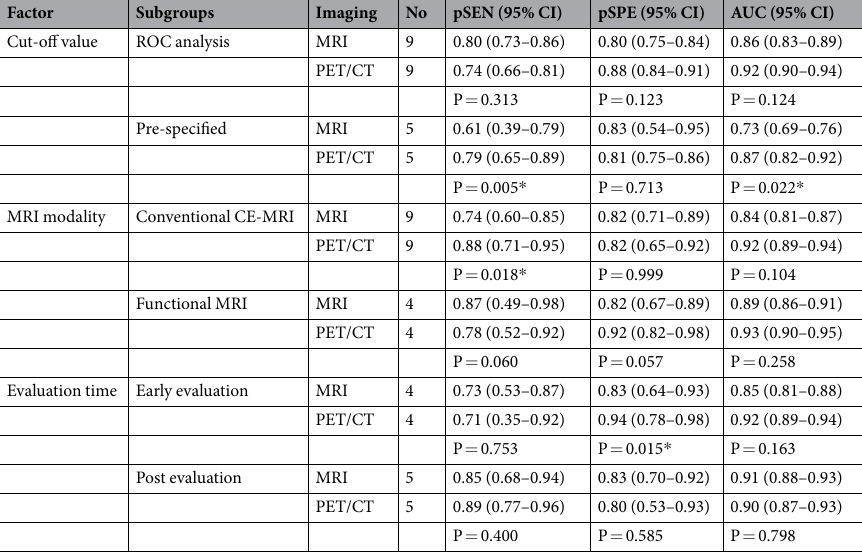
Table 3. Accuracy estimates for subgroup analyses. pSEN = pooled sensitivities; pSPE = pooled specificities; * P <